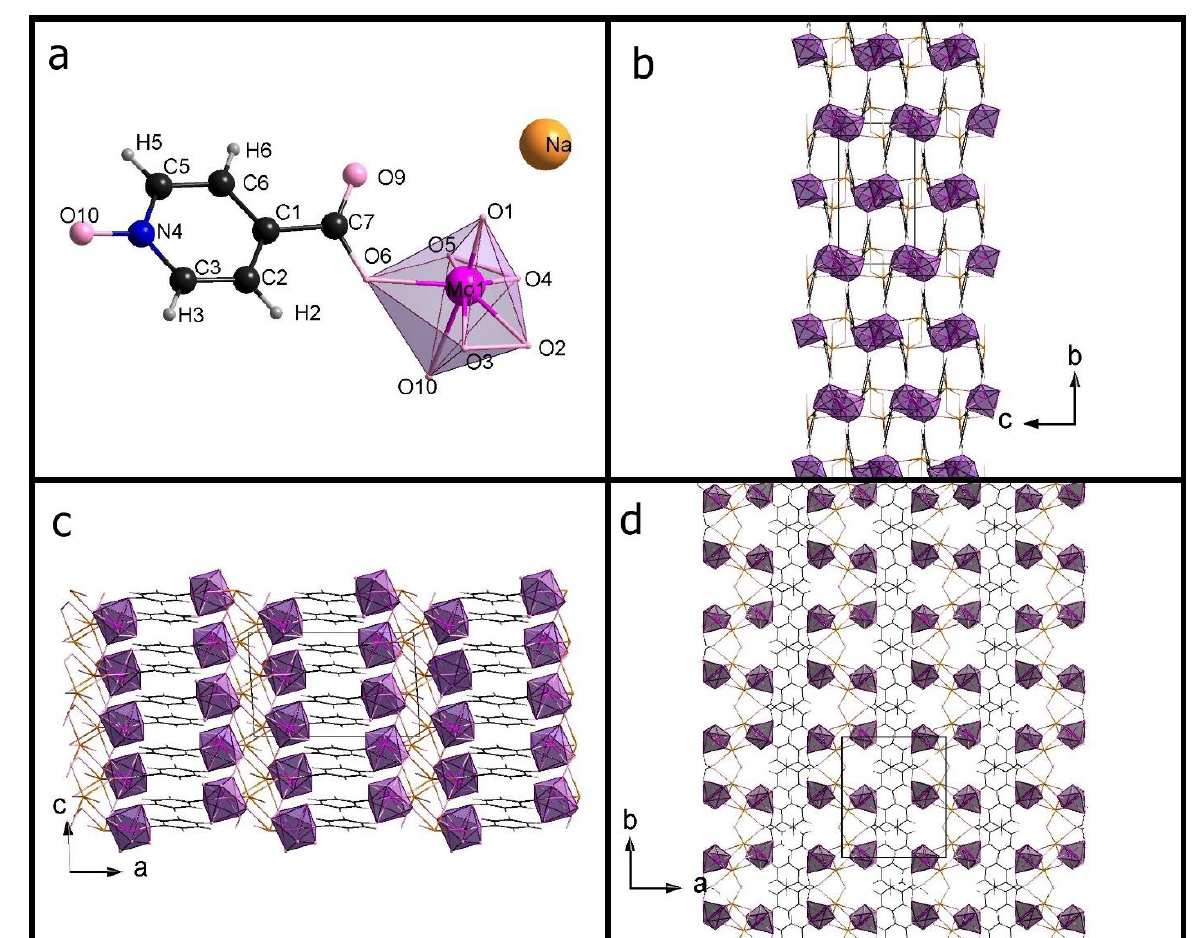
Figure 2. The asymmetric unit of Na-isoO ( a ); packing diagram of Na-isoO along the a-axis ( b ), along the b-axis ( c ), along the c-axis ( d ).